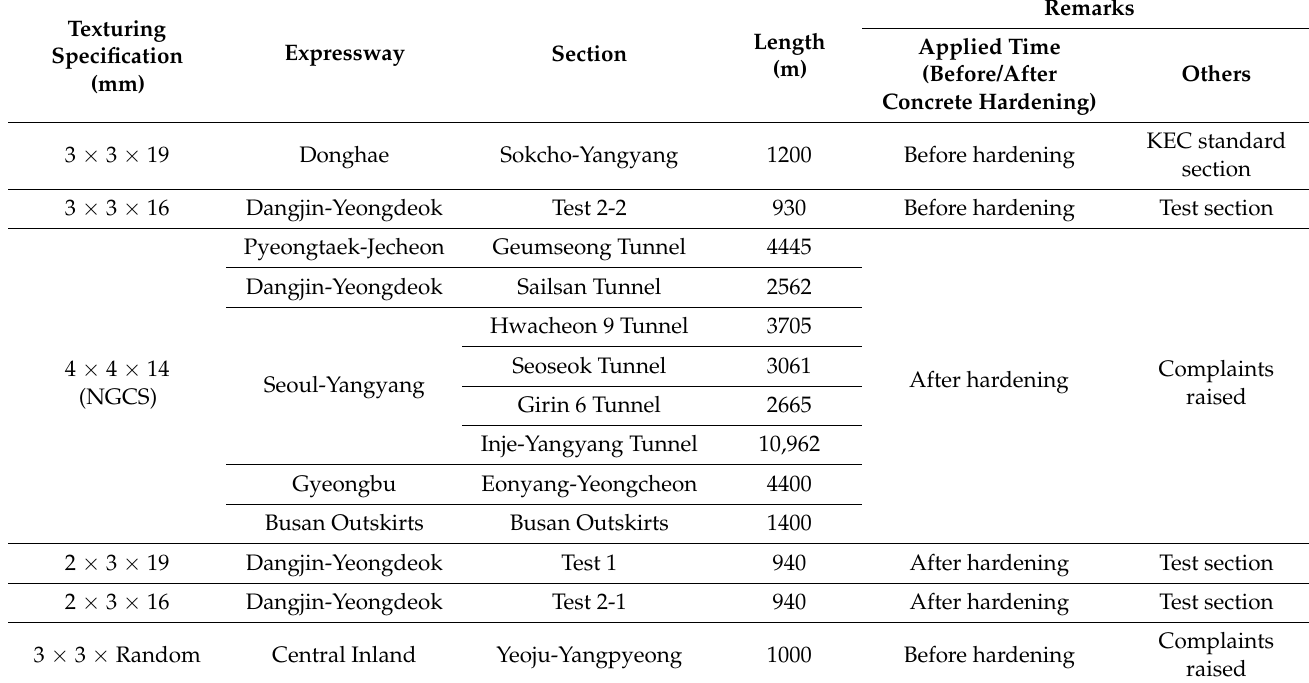
Table 1. Sections selected for field